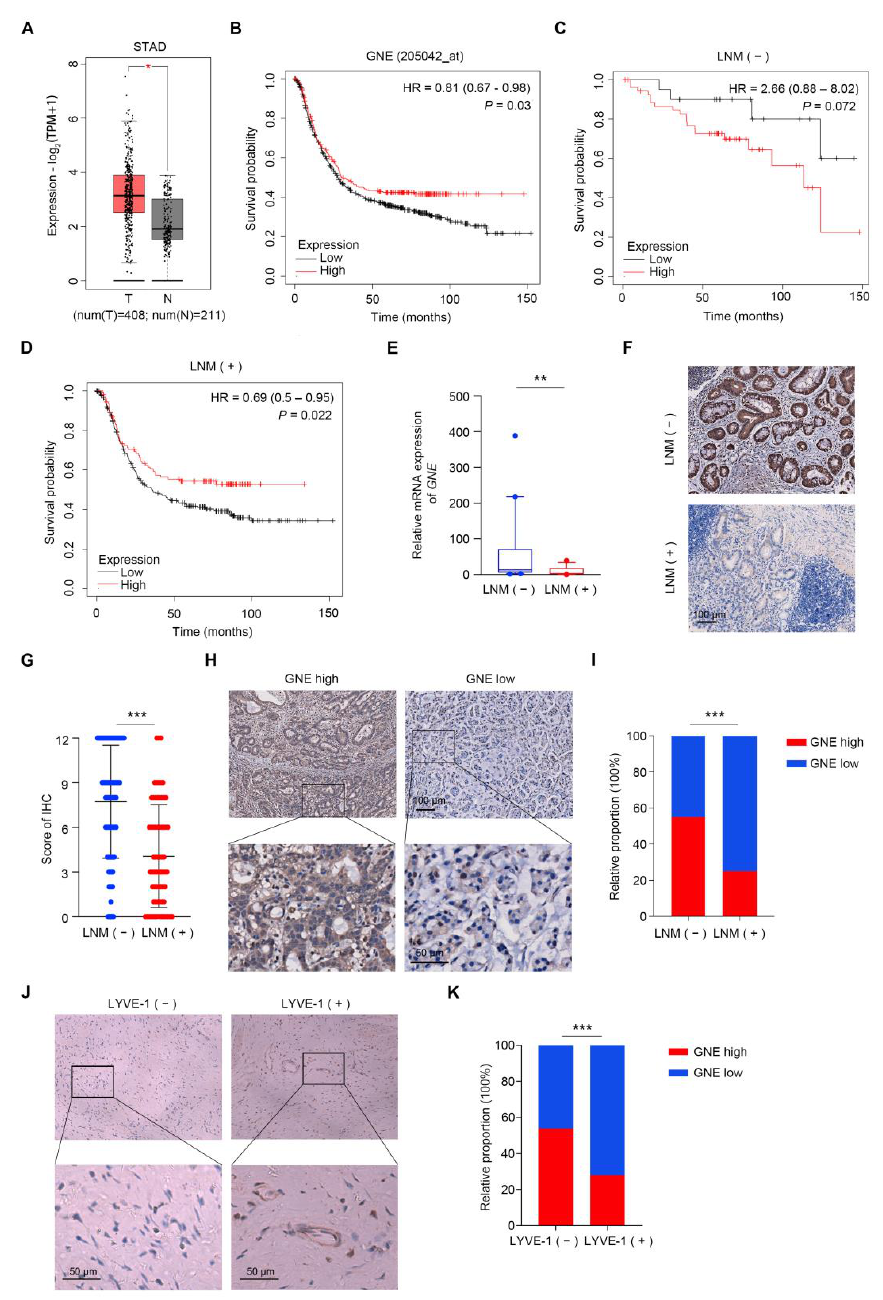
Figure 1. GNE is down-regulated in EGCs with lymph node metastasis. ( A ) Results of analysis of GNE expression level in tumor (T) and normal (N) of TCGA_STAD dataset from GEPIA database; ( B – D ) correlation of GNE with the survival of gastric cancer patients was analyzed utilizing an online survival analysis software (https://kmplot.com/analysis/index.php?p=service&cancer=gastric (accessed on 5 May 2022)); ( B ) all gastric cancer patients; ( C ) group of gastric cancer patients without LNM; ( D ) group of gastric cancer patients with LNM; ( E ) the mRNA levels of GNE were evaluated in fresh EGC tissues with ( n = 16) or without ( n = 25) LNM; ( F , G ) GNE expression was assessed by immunohistochemistry in TMA containing EGC specimens with or without LNM. Representative images are shown in ( F ); ( H ) representative images of GNE low- and high-expression tissues; ( I ) the classification of patients with high or low expression of GNE in LNM ( − ) and LNM (+) groups in percentage terms; ( J ) representative images of LYVE-1 ( − ) and LYVE-1 (+) tissues; ( K ) the classification of patients with high or low expression of GNE in LYVE-1 ( − ) and LYVE-1 (+) groups in percentage terms. *, p < 0.05; **, p < 0.01; ***, p <